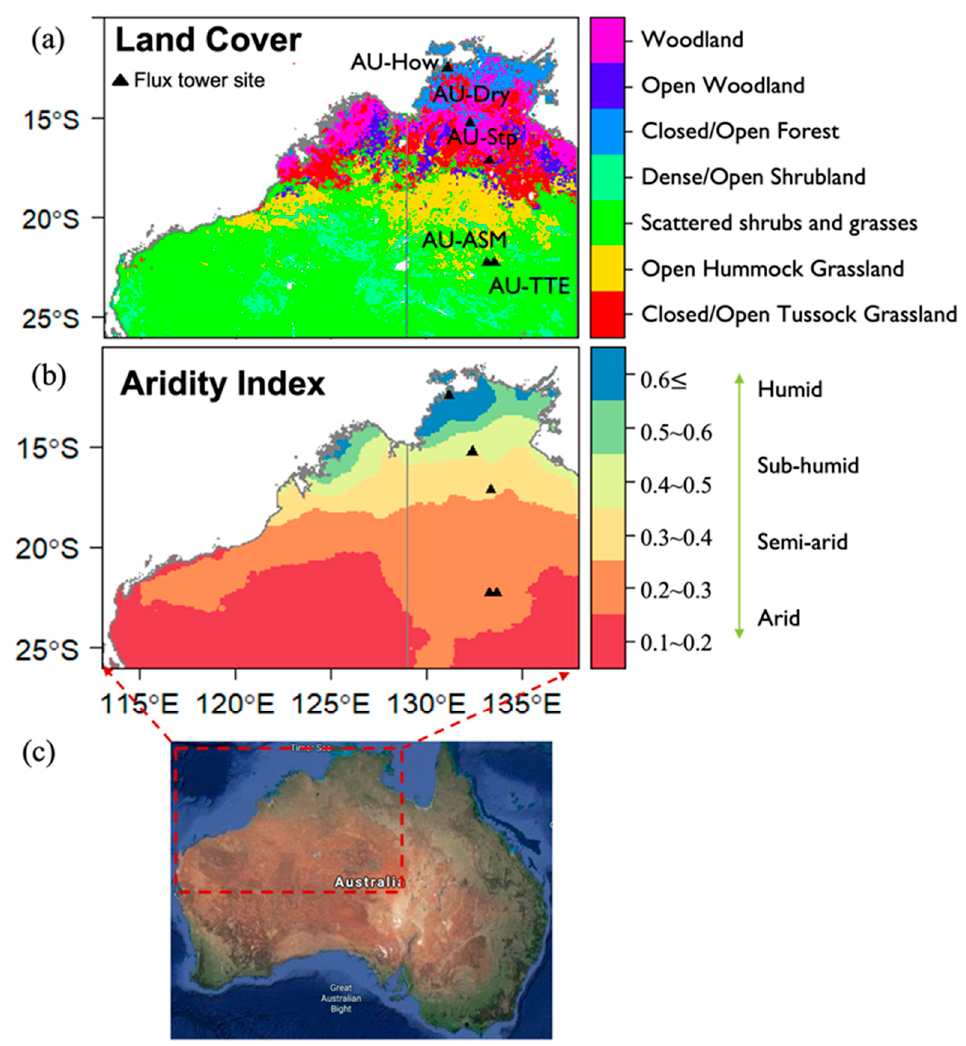
Figure 1. ( a ) Land cover map based on national Dynamic Land Cover Dataset. ( b ) Spatial pattern of aridity index. ( c ) The locations of study area over Australian continent (image source: Google Earth). Black triangles refer to five flux tower sites.